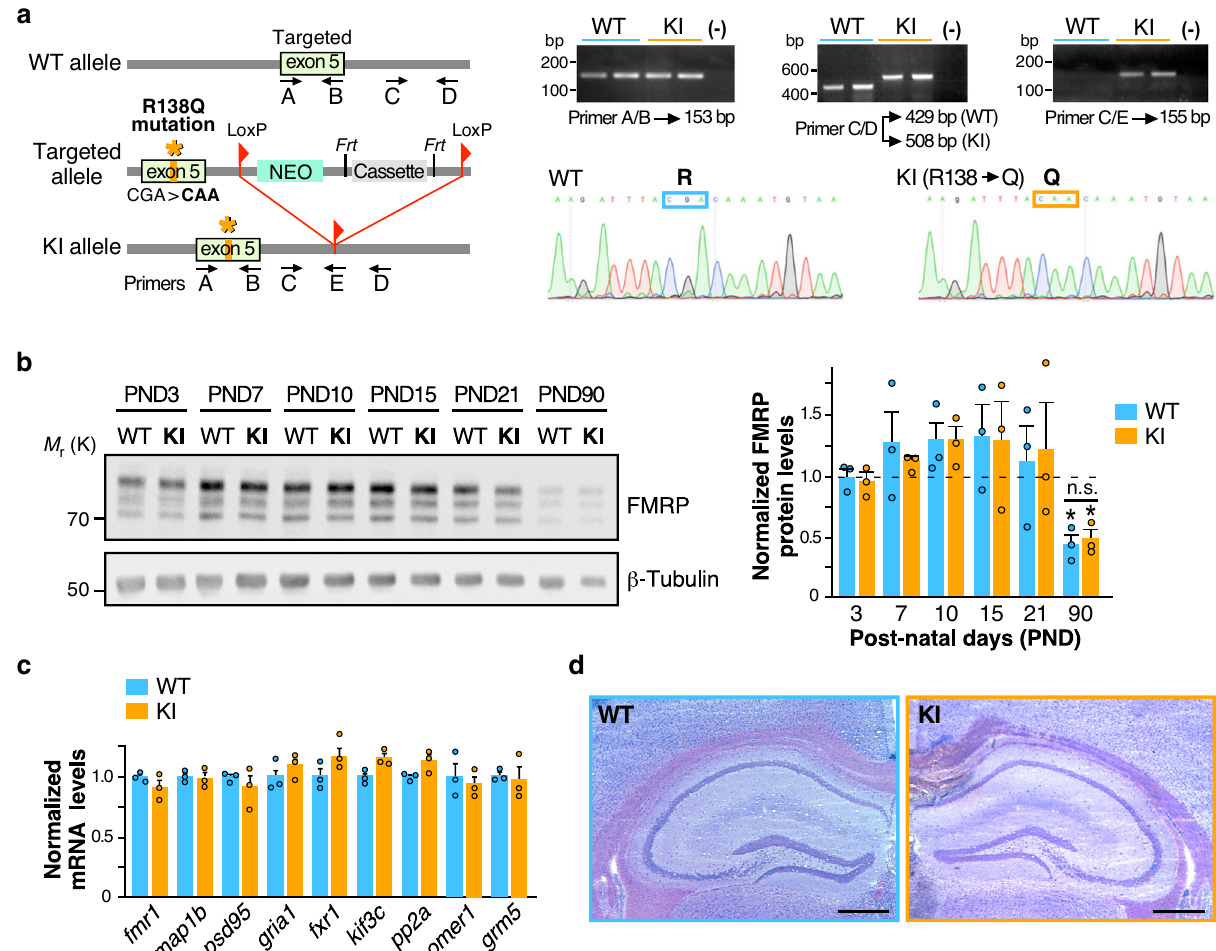
Fig. 1 Generation and characterization of the Fmr1 R138Q Knock-in (KI) mouse line. a Schematic representation of the Fmr1 WT allele, the targeting vector used and the allele carrying the missense FXS R138Q mutation. Representative PCR pro fi les and DNA sequences obtained upon genotyping and genomic DNA sequencing of WT and Fmr1 R138Q littermates. b Immunoblots showing FMRP protein levels at the indicated postnatal days (PND) in WT and Fmr1 R138Q mice. β 3-tubulin loading control is also shown. Data are presented as mean values ± s.e.m. of normalized FMRP-WT and FMRP-R138Q protein levels in developing brains of age-matched littermate animals. N = 3 biologically independent experiments. Statistical signi fi cance determined by Two-way analysis of variance (ANOVA) with Sidak ’ s post test; * p = 0.0219 versus PND3 – 21; ns not signi fi cant. c Relative abundance of several mRNA targets of FMRP measured by qPCR in PND90 WT and Fmr1 R138Q brains. Data are presented as mean values ± s.e.m. of three biologically independent experiments. No signi fi cant differences were observed between the genotypes. d Representative images of the hippocampal formation in PND90 WT and Fmr1 R138Q littermates. Scale bar, 300 μ m. Source data are provided as a Source Data fi synaptic vesicles in Fmr1 R138Q hippocampal presynaptic termini m). Taken together, these data indicate that the R138Q mutation (Fig. 2c; WT: 120.48 ± 4.65 vesicles per μ m 2 ; Fmr1 R138Q : 148.97 ± 4.25 vesicles per μ m 2 ). Altogether, these data reveal that the R138Q mutation leads to ultrastructural alterations both in the pre- and postsynaptic compartments.